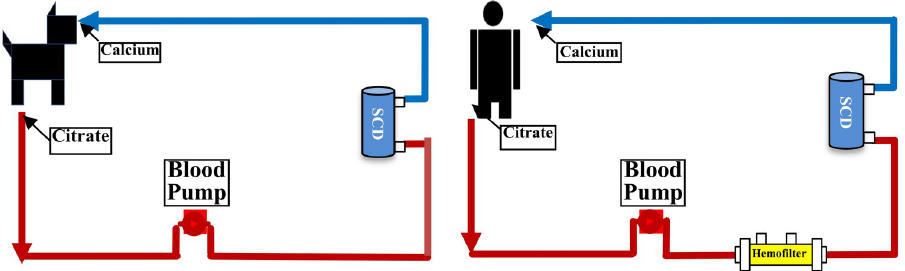
Fig 1. Schematic of extracorporeal blood circuits integrating SCD in canine and human studies. Left panel displays the extracorporeal circuit for SCD treatment in the canine model of HF/HFrEF. Blood flow rate was 100ml/min, citrate (ACD-A) was administered at 180 ml/hour and 2% CaCl2 was given at 40 ml/min to maintain systemic and circuit iCa between 0.9 to 1.4 and 0.25 to 0.4 mmol/L, respectively. Right panel displays the extracorporeal circuit for SCD treatment for human subjects. Blood flow rate was 80 ml/min. Citrate (ACD-A) and CaCl 2 were administered as per protocol (S1 Appendix) to maintain systemic and circuit iCa between 0.9–1.4 and 0.25–0.4 mmol/L, respectively. The hemofilter was placed in the circuit to improve citrate removal to minimize any tendency to citrate toxicity during treatment.